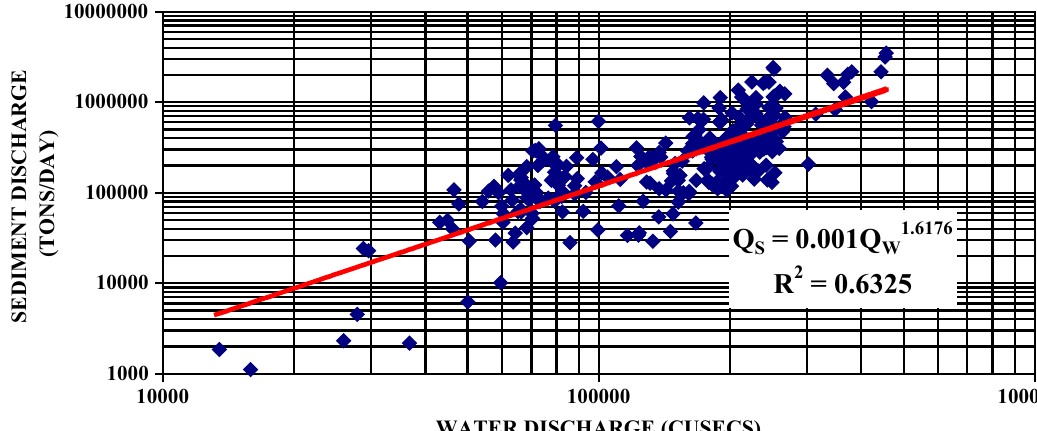
Fig. 2 Sediment rating